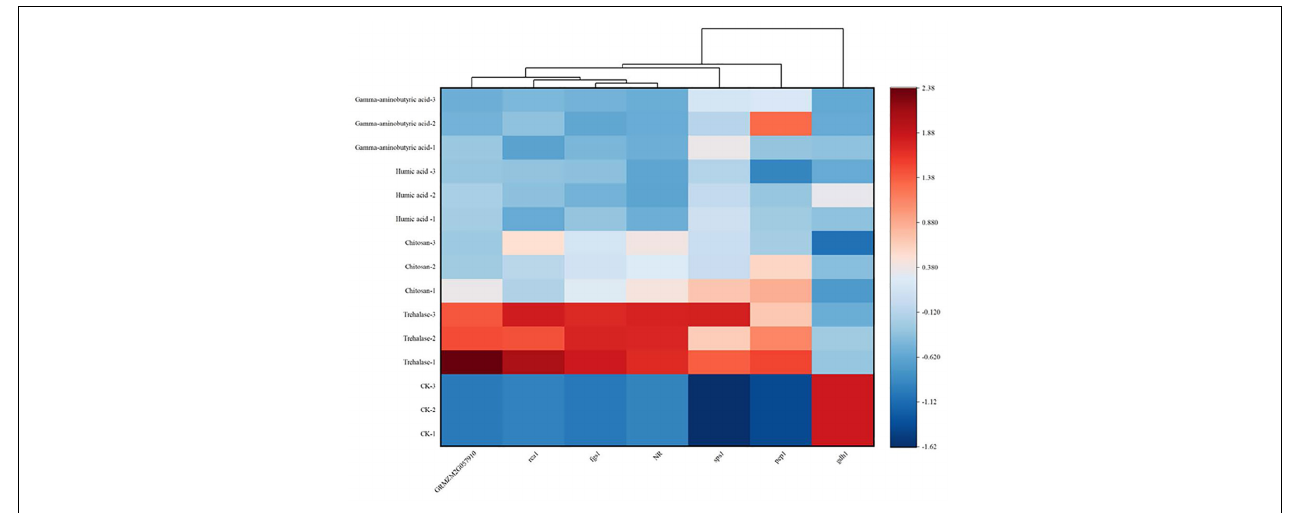
FIGURE 5 | Heat map of differentially expressed genes in maize leaves treated with plant growth regulators (PGRs) at the six-leaf stage of vegetative growth (V6) stage. Columns and rows in the heatmap represent genes and samples, respectively. The sample names are displayed to the left of the heatmap. The color scale indicates fold changes in gene expression. Blue and red indicate decreases and increases in transcript abundance, respectively. A cluster analysis of differentially expressed genes is shown above the figure. Heat maps were drawn with Origin software (2021b) based on normalized Z